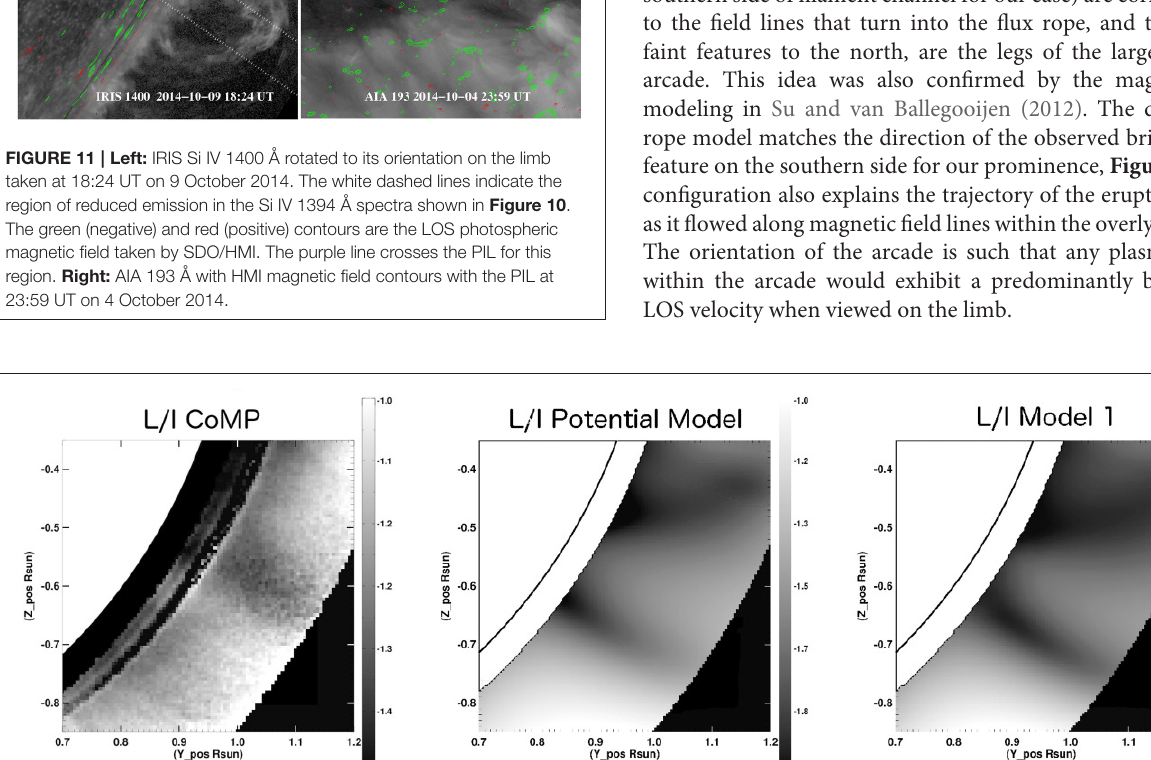
Frontiers in Astronomy and Space Sciences |